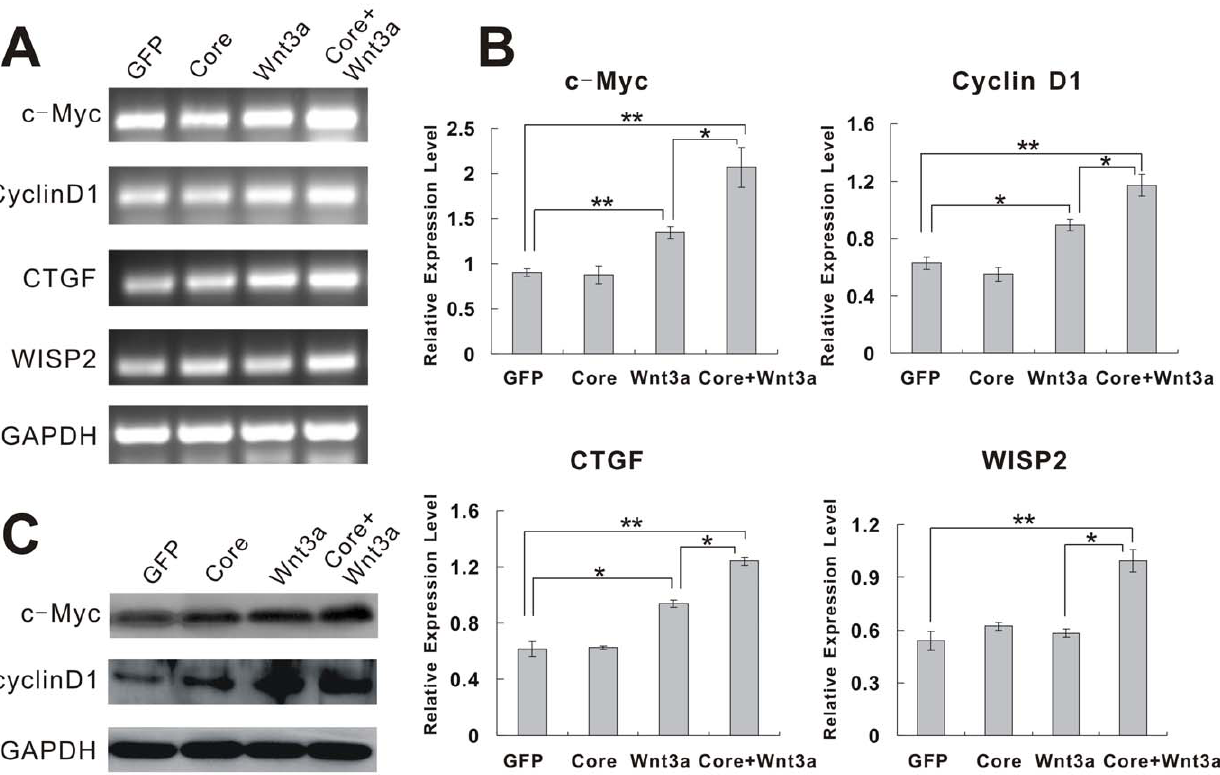
Figure 3. HCV core enhances Wnt3A-induced target genes expression. ( A ) Semi-quantitative RT-PCR analysis of the mRNA expression for known Wnt target genes after ectopic expression of HCV core and/or Wnt3A. Huh7 cells were infected with Ad-Core, AdWnt3A, AdGFP control or Ad- Core plus AdWnt3A for 36 hr. Total RNA was isolated for RT-PCR analysis using primers specific for indicated genes. Data were obtained from three independent experiments, and representative results are shown. All samples were normalized with GAPDH. ( B ) Quantitative analysis of target gene mRNA expression level. The expression level of c-Myc, cyclinD1, CTGF and WISP2 were detected by qRT-PCR. Data are shown as the means 6 S.D from three independent experiments. * p , 0.05; ** p , 0.01. ( C ) HCV core enhances Wnt3A-induced downstream genes at protein level. Cells were treated as described in Figure 3A , and then total cell lysate was prepared at 48 hr after infection. C-Myc and cyclin D1 expression was assessed by Western blotting using respective antibodies. GAPDH was used as a loading control. Data were obtained from three independent experiments, and representative results are shown.